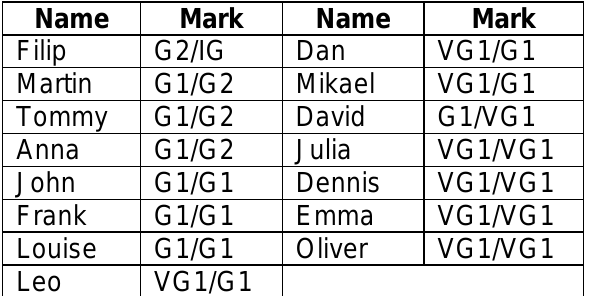
Table 1 indicates that Tommy is able to solve